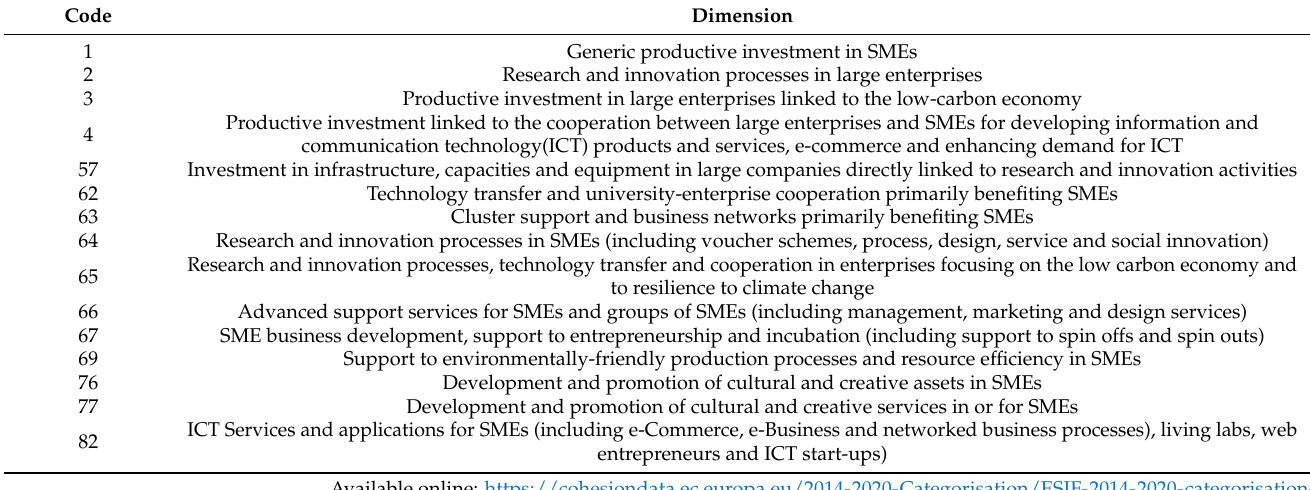
Table 2. Dimensions of intervention in TO 1.